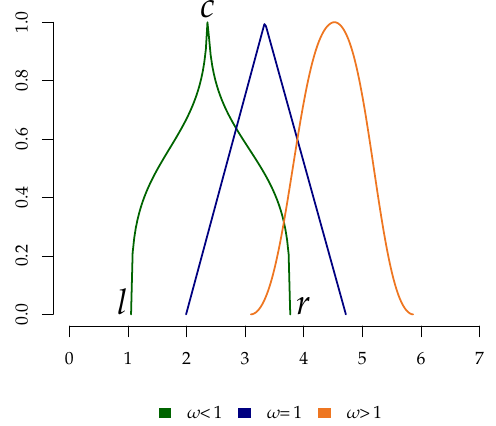
Figure 1. Exemplification of four-parameter triangular fuzzy numbers represented in terms of the ω parameter. Note that c , l , r are the center, left and right bounds respectively.